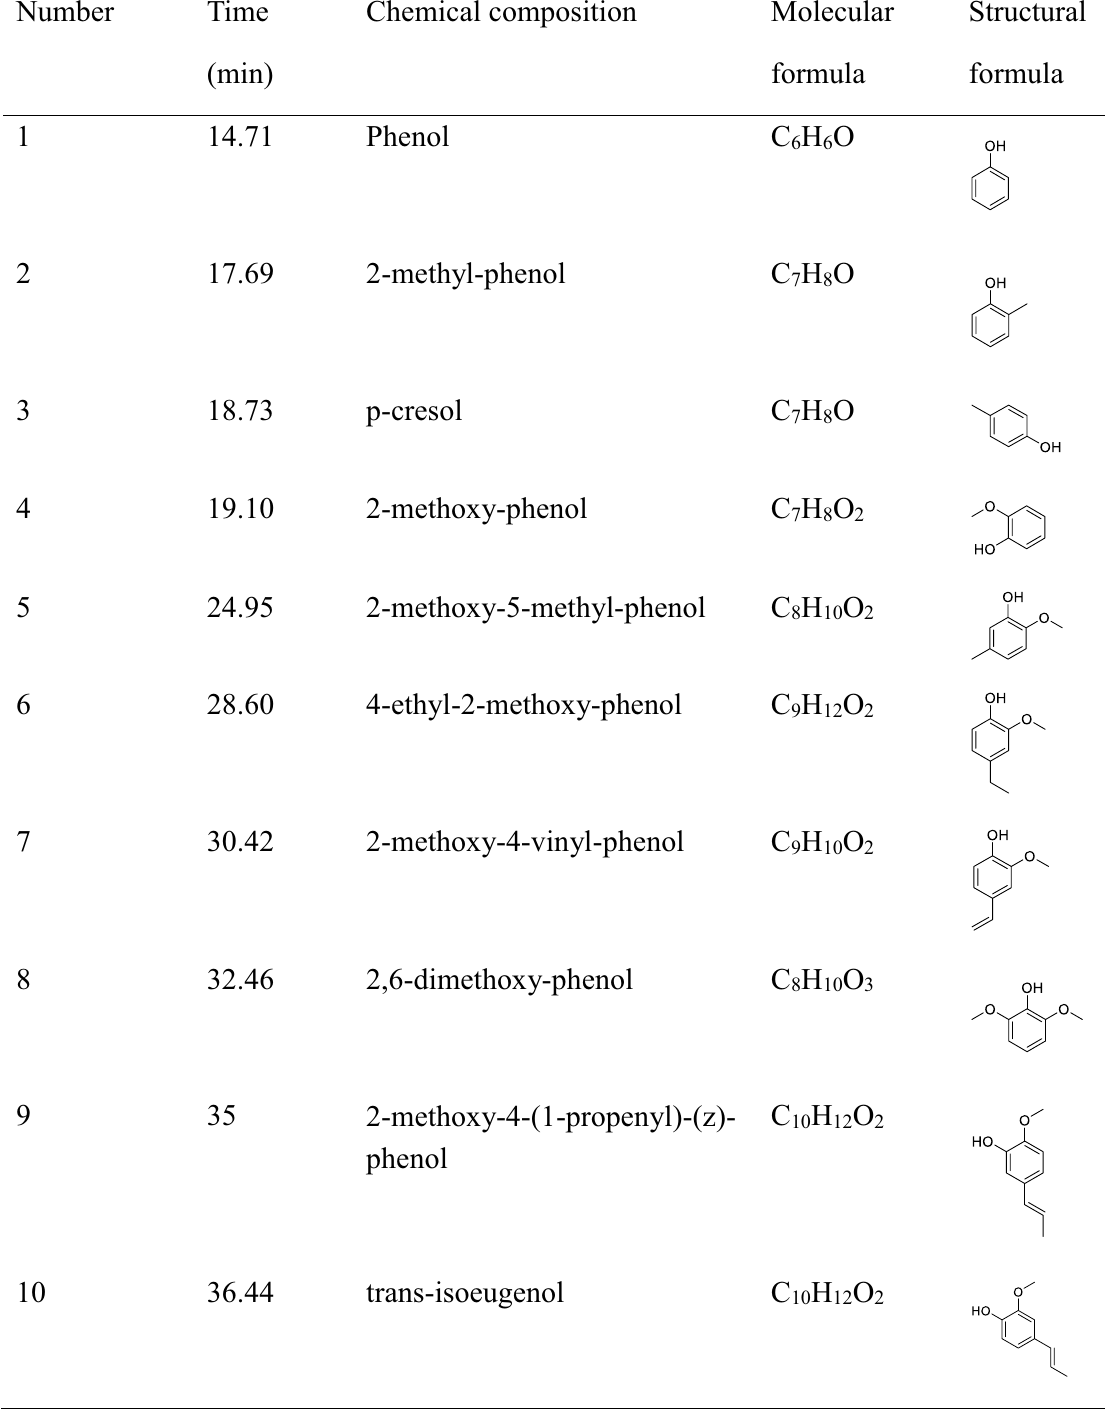
Table 3 The phenolic components in chestnut